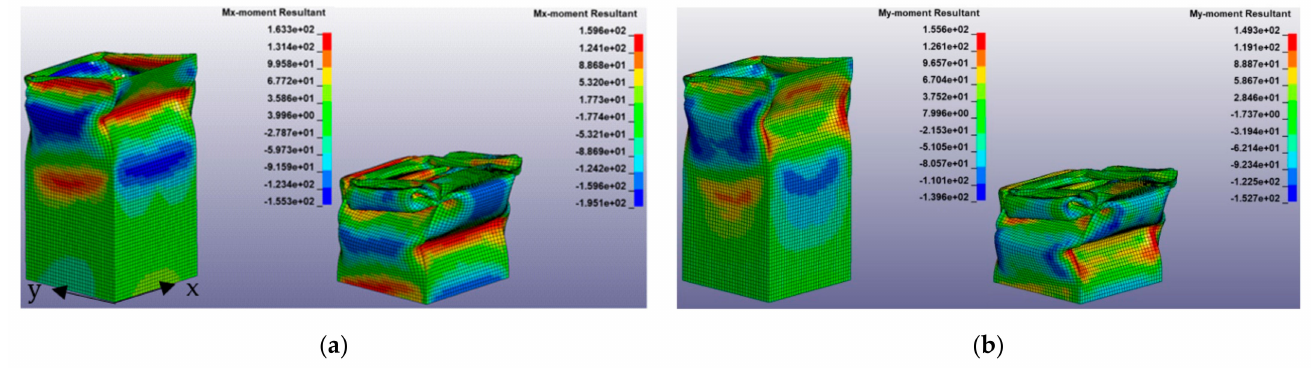
Figure 16. Bending moment circumferential distribution during collapse for 10 ◦ edged oblique impact. ( a ) M x moment; ( b ) M y